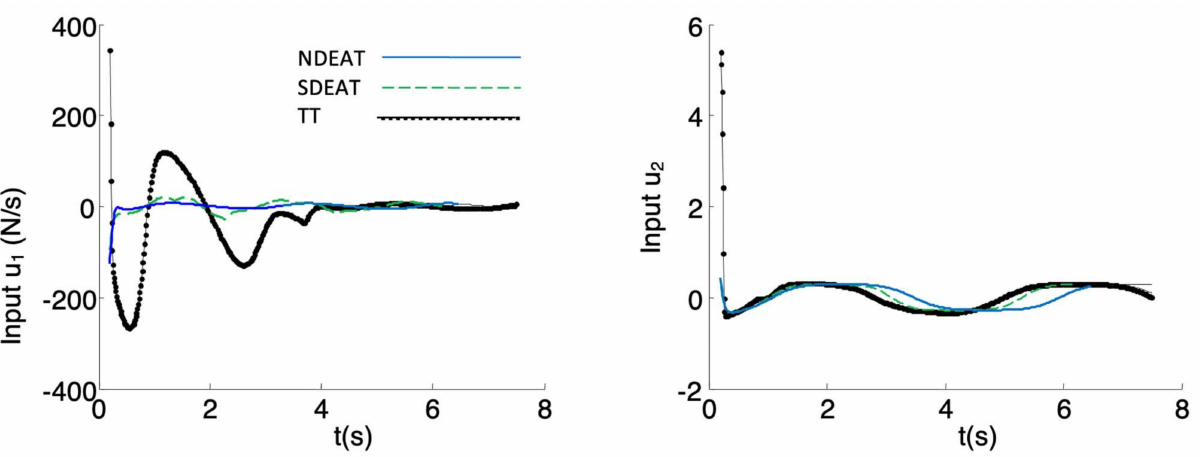
Figure 7. Inputs u when the robot is delayed. During transients, NDEAT demands less input than SDEAT, and SDEAT demands much less than TT. The first instants are not depicted because TT inputs rise to very high values, which would reduce the scale of the plot too much.